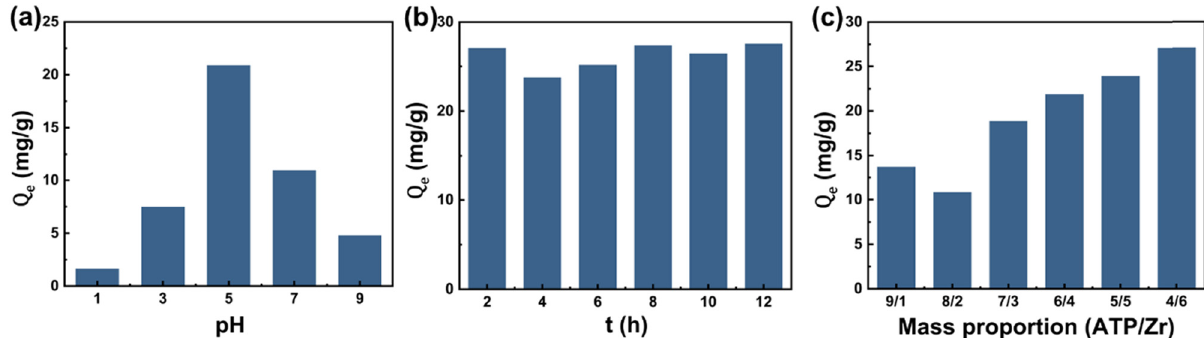
Figure 1: The optimal preparation condition of Zr@ATP, the e ff ect of ( a ) reaction pH, ( b ) reaction time, and ( c ) mass